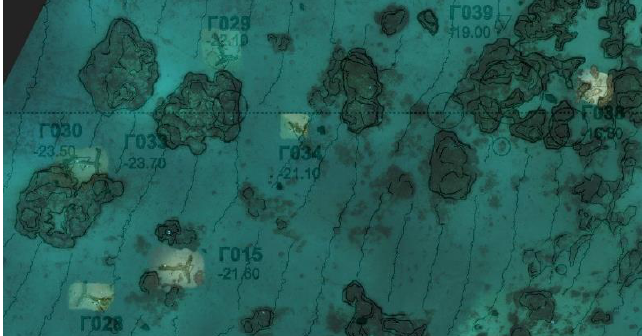
Figure 9: Digitization of orthophotomosaic (©H.I.M.A. 2015)